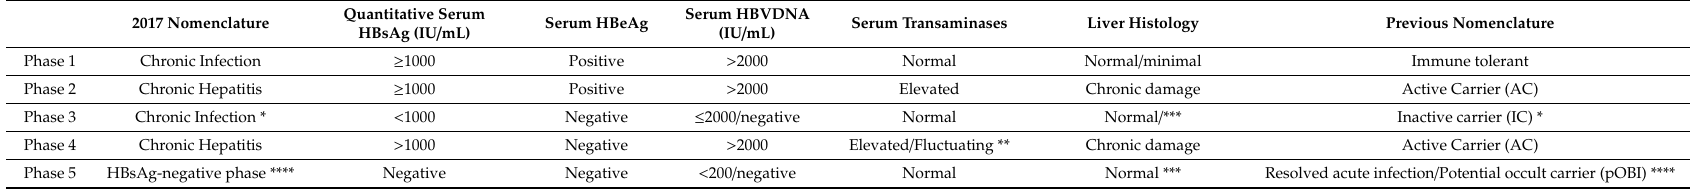
Table 1. Main characteristics of HBV infection virological categories, a simplified